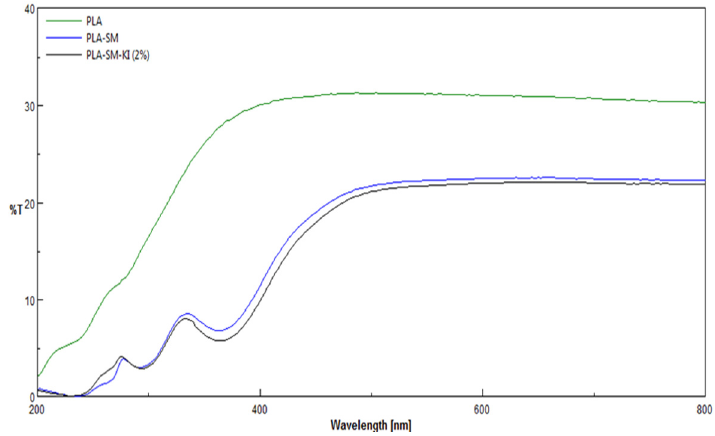
Figure 10. Comparison of UV / VIS transmittance spectra T = f ( λ ) (T [%] vs. λ [nm]) of PLA, PLA-SM and PLA-SM-KI (2%), recorded in the range λ = 200–800 nm.